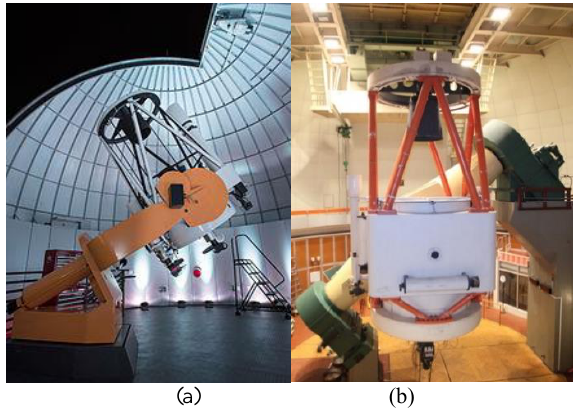
Figure 9 (a) the Ritchey-Chrétien telescope in